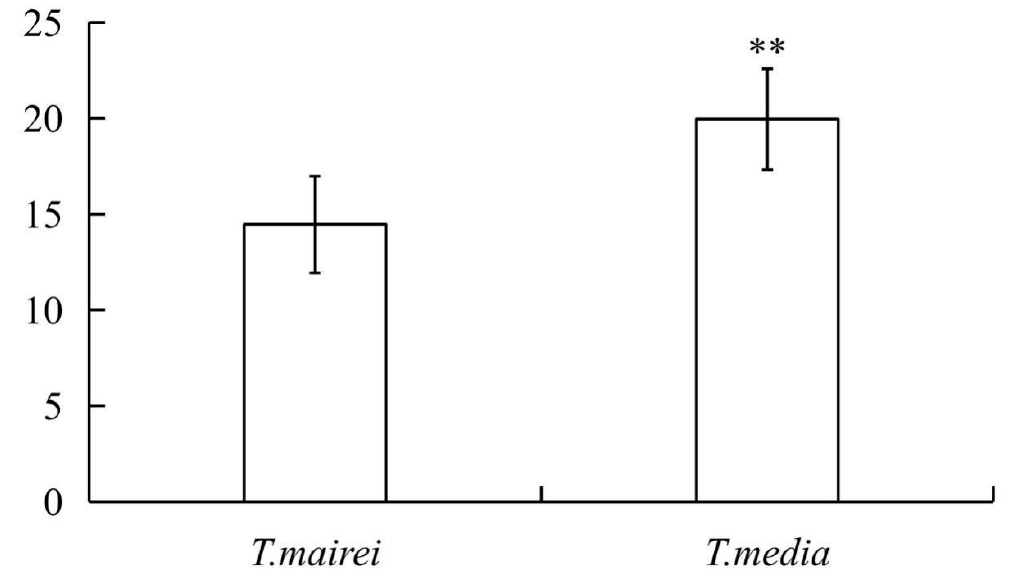
Figure 1. Variations of the total flavonoid contents in the needles of Taxus mairei and Taxus media samples. Significant variations ( p < 0.01) are indicated by **. Error bars represent means ± SD ( n = 8).